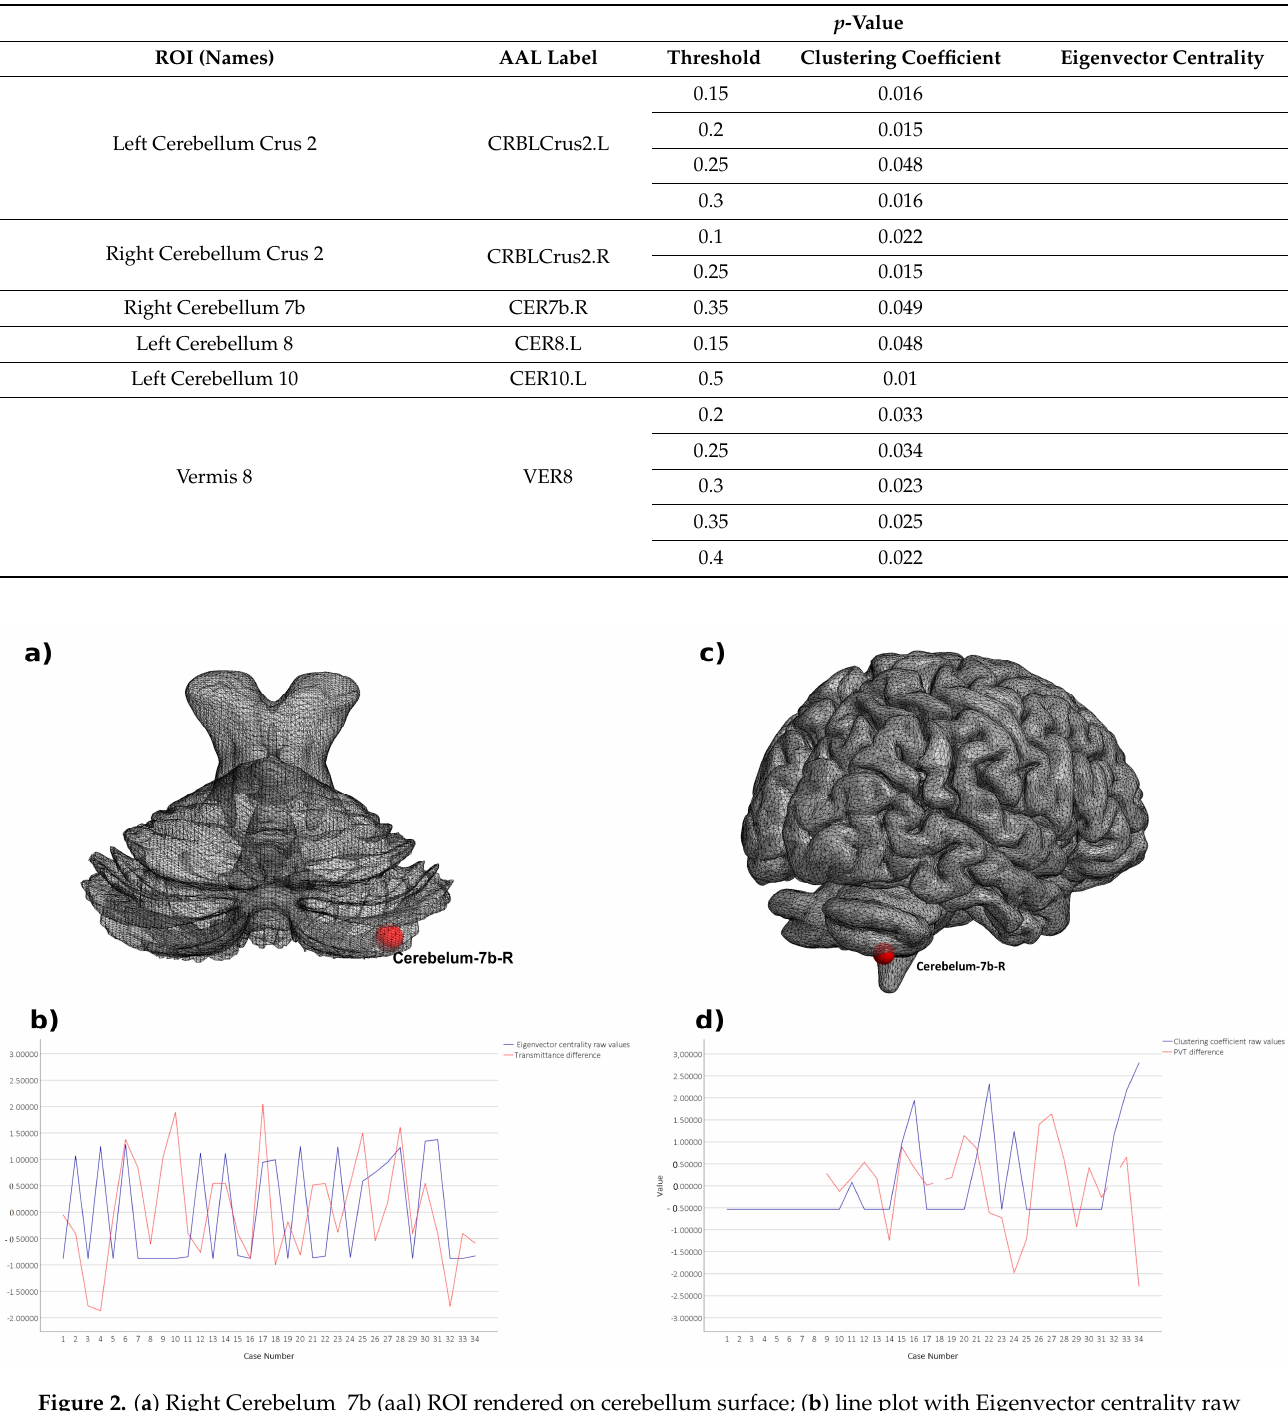
Figure 2. ( a ) Right Cerebelum_7b (aal) ROI rendered on cerebellum surface; ( b ) line plot with Eigenvector centrality raw values and absolute difference in transmittance of each participant; ( c ) Right Cerebelum_7b (aal) ROI rendered on the cortical surface; ( d ) line plot with Clustering coefficient raw values and the difference in PVT of each participant; * values for each index were z-score for the purpose of visualization.